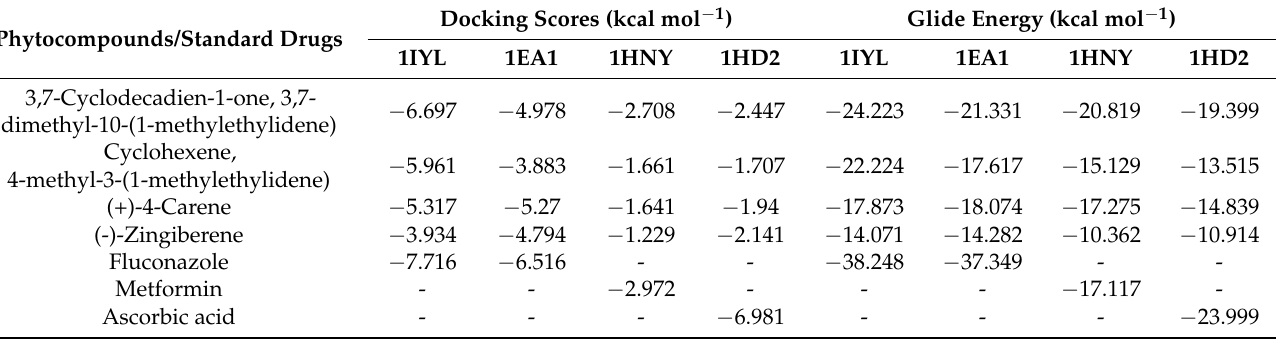
Table 4. Docking scores of phytocompounds and standard drugs with target protein